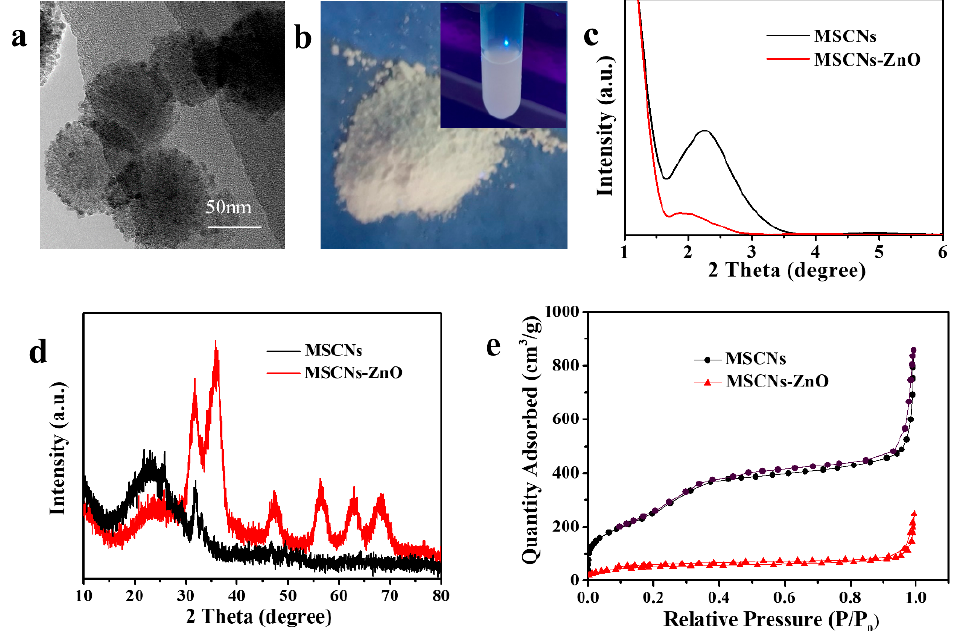
Figure 9. ( a ) TEM images of MSCNs-ZnO. ( b ) Photographs for power and aqueous solution (the inset image) of MSCNs-ZnO under 365 nm UV irradiation. ( c ) SAXRD patterns of MSCNs and MSCNs-ZnO. ( d ) WAXRD patterns of MSCNs and MSCNs-ZnO. ( e ) Nitrogen adsorption desorption isotherms of MSCNs and MSCNs-ZnO.